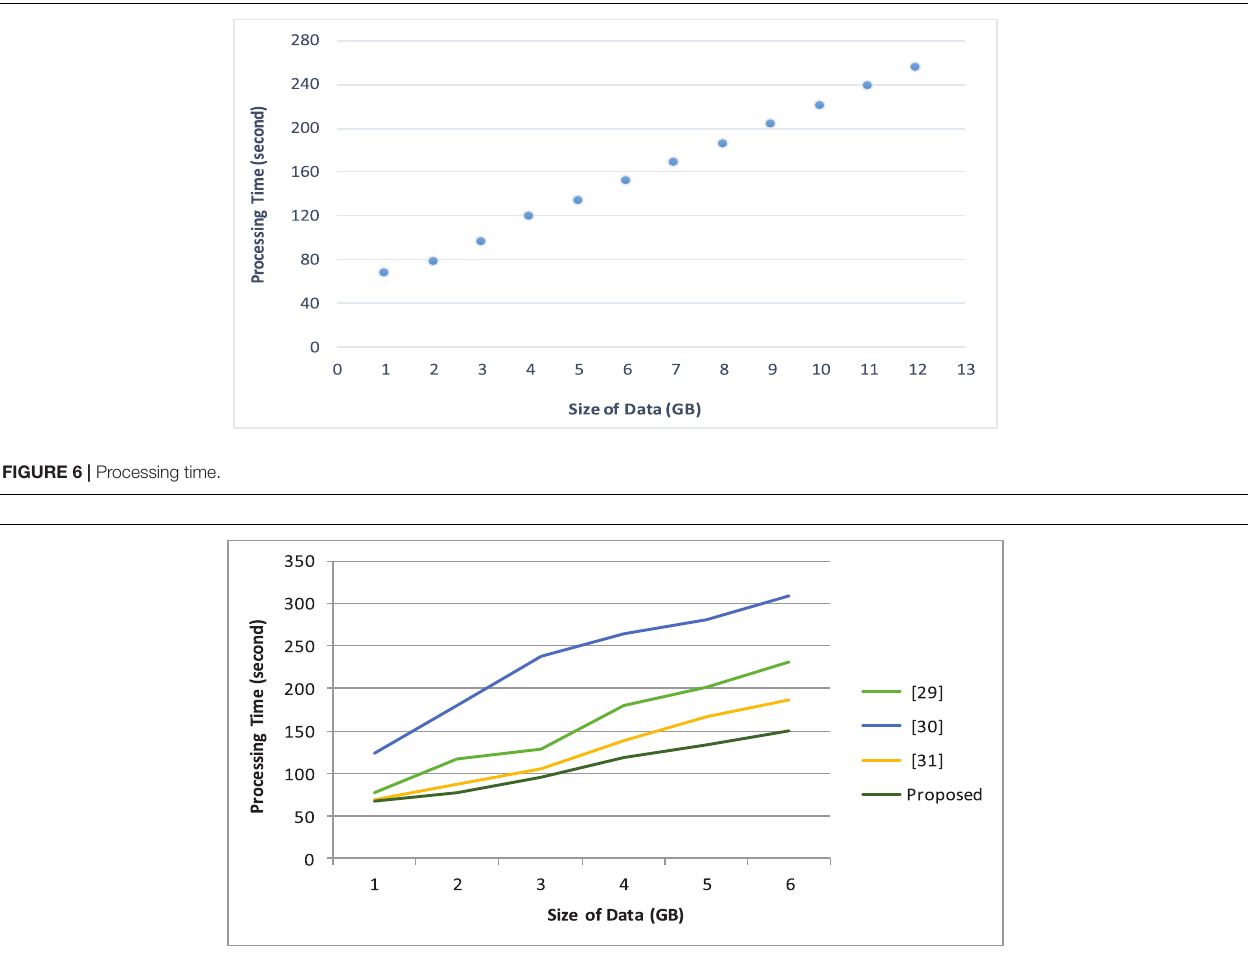
FIGURE 7 | Comparative